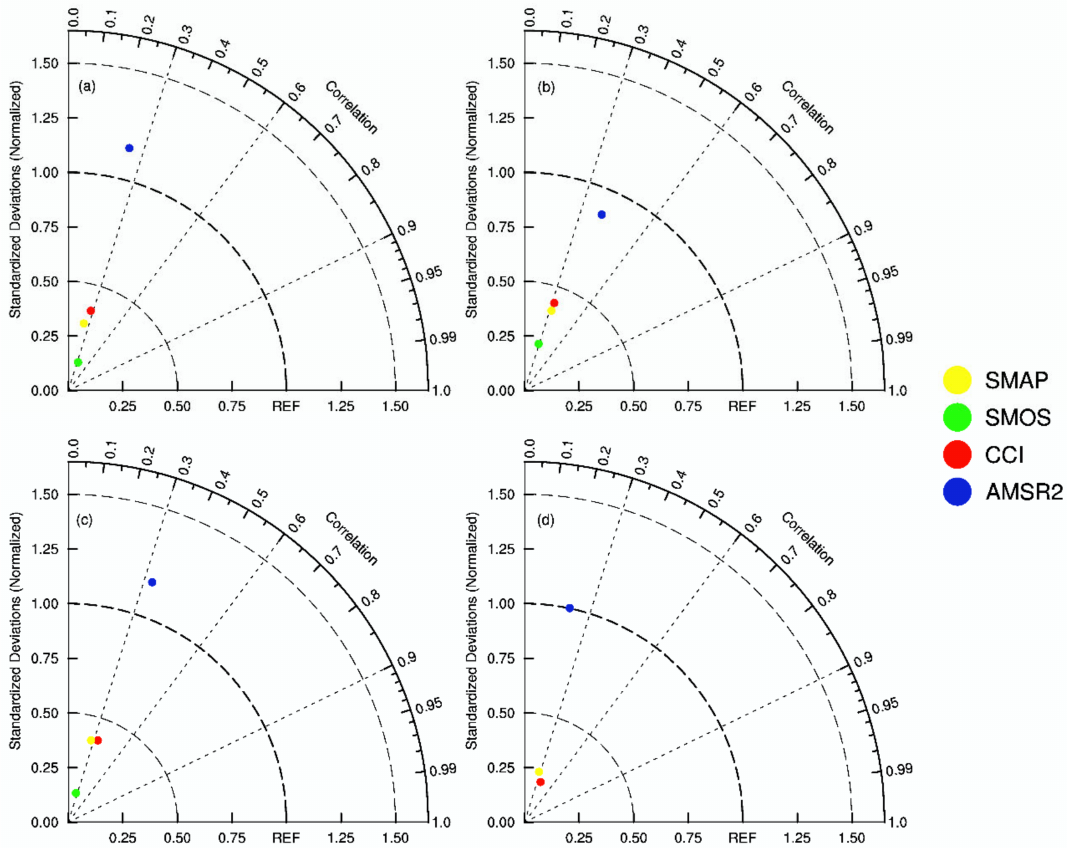
Figure 7. Taylor diagrams of soil moisture products in different seasons: ( a ) spring; ( b ) summer; ( c ) autumn; ( d )